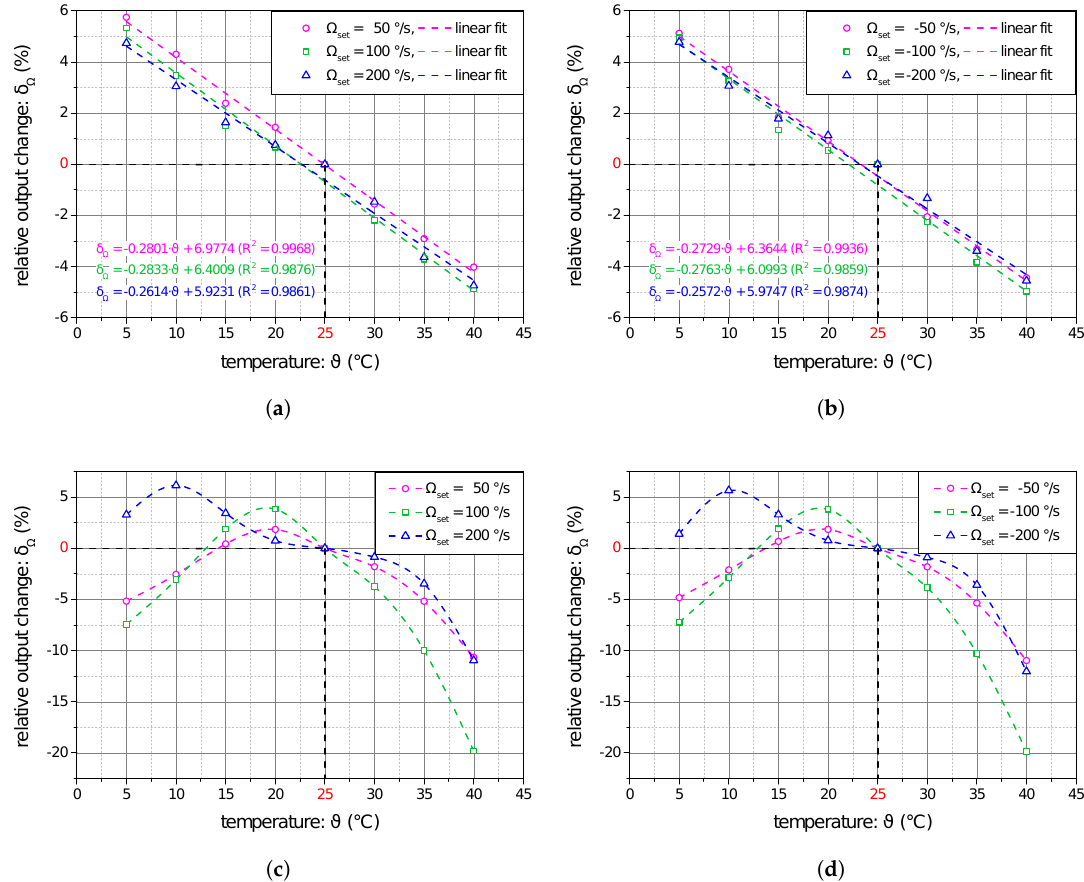
Figure 12. The measured temperature-dependent relative change of the I-FOG output signal for closed-loop ( a , b ) and open-loop ( c , d ) operation ( ϑ ref = 25 ◦